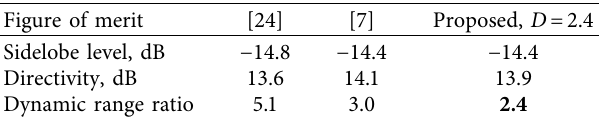
Table 3: Properties of proposed pencil beam array with 30 elements and beamwidth of 6 ° , compared with array having equiripple sidelobes and unconstrained DRR [24], and with array having minimum DRR for given SLL and all positive coefcients [7]. Improvement is highlighted in bold.